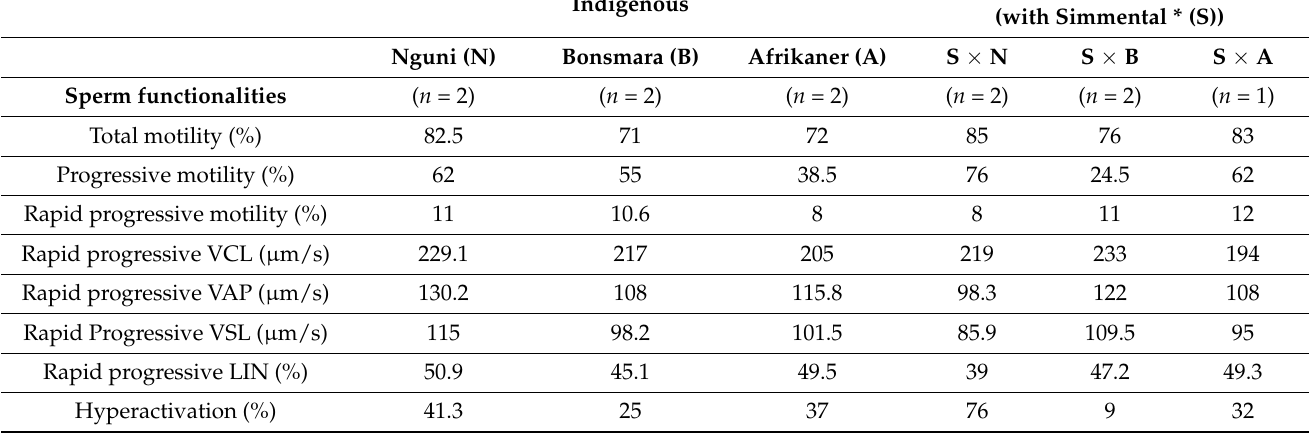
Table 6. Comparison of semen and sperm functional characteristics of indigenous and crossbred bulls in South Africa to consider similarities in sperm motility parameters. All three crossbreds were between Simmental as the exotic breed and one of the indigenous southern African cattle breeds. This data forms part of a preliminary study where sperm motility assessments were performed by means of computer-aided sperm analysis (CASA) at a high frame rate (169 frames per second), and bulls were randomly selected for measurement (unpublished research). Crossbreeds Indigenous (with Simmental * (S)) Nguni